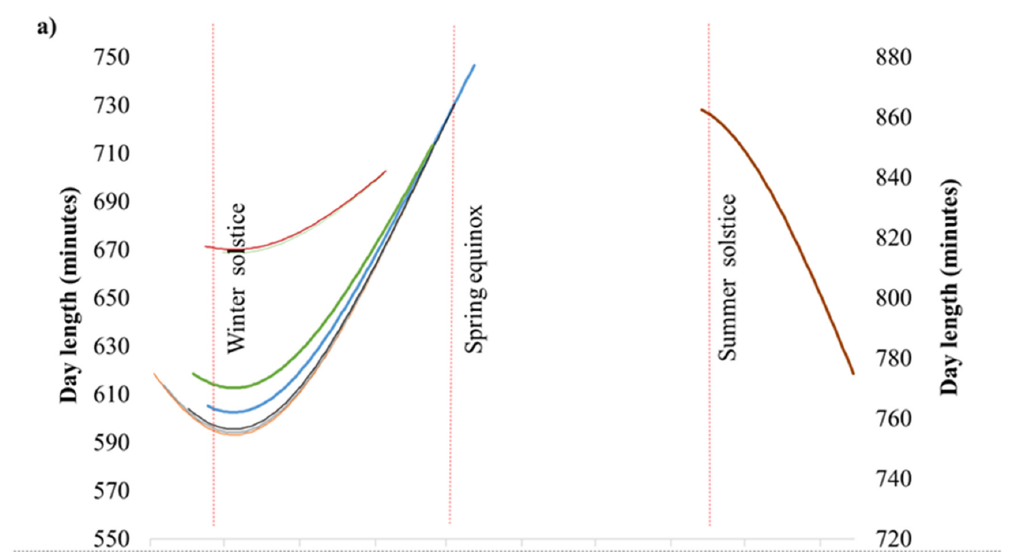
Figure 1. Distribution of ( a ) day length and ( b ) average temperature during the crop season at 13 environments including eight locations. The environments included are Kaedi (KED) 2015 and 2016 in Mauritania; Fanaye (FAN) 2015 and 2016 in Senegal; Marchouche (MCH) 2015 and 2016, Melk Zhar (MKZ) 2015 and 2016, and Tessaout (TES) 2016 in Morocco; Terbol (TER) 2015 and 2016, Kfardan (KFD) 2016, and Terbol off (TerOff) season 2016 in Lebanon. This last environment was plotted in the right axis to simplify visualization.